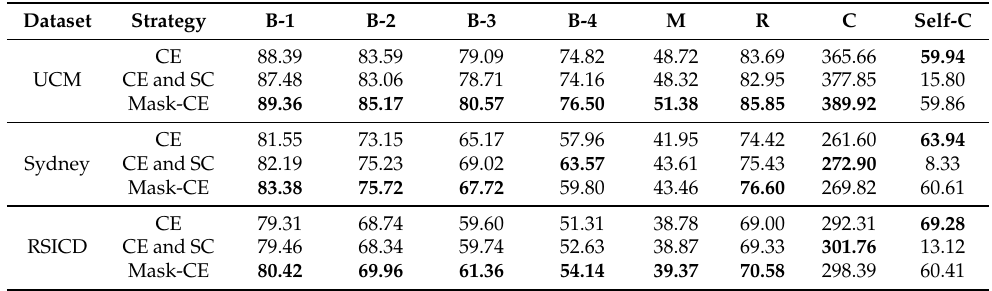
Table 5. Comparison scores (%) of different strategies on RSICD data set. B, M, R, C, and Self-C represent BLEU, Meteor, Rouge-L, CIDEr, and Self-CIDEr, respectively.